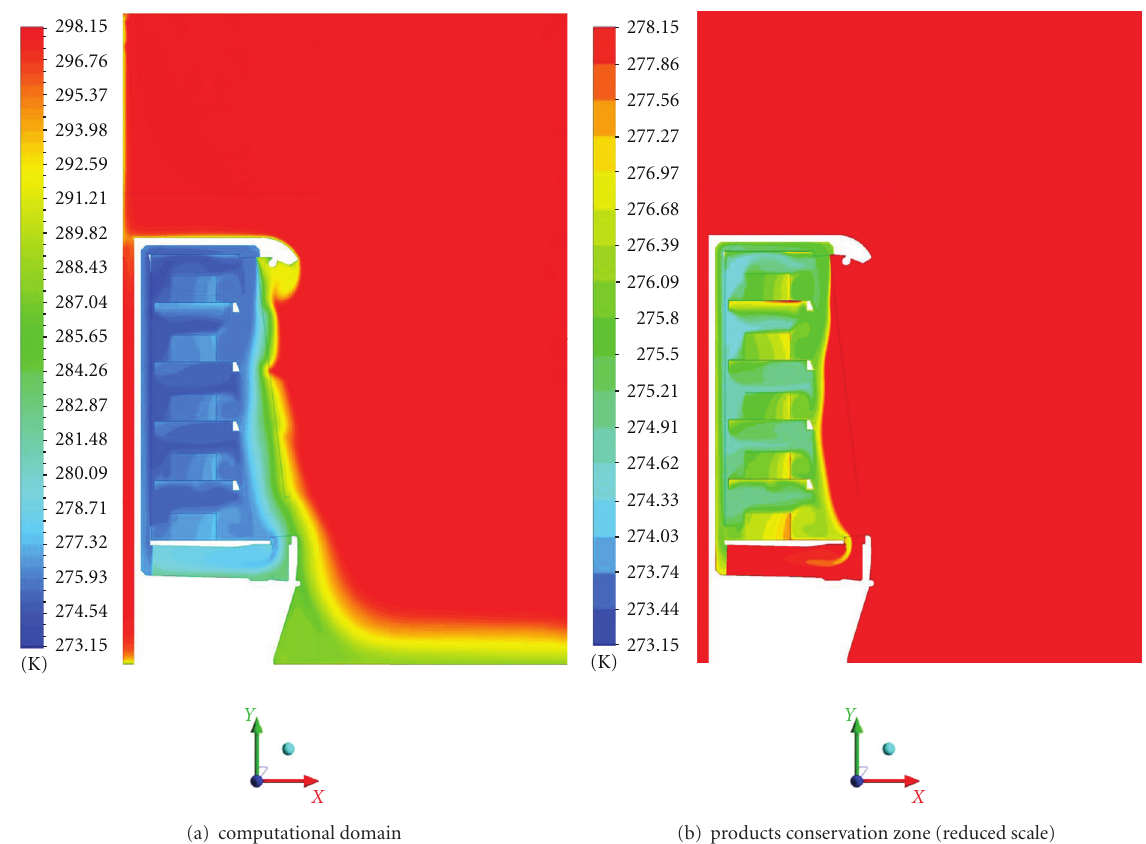
Figure 9: Temperature field numerical predictions, T